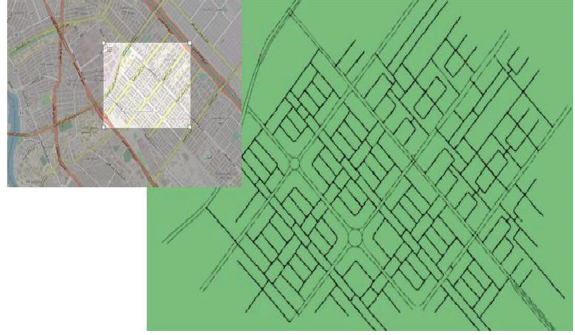
Figure 4: Map of Baghdad in